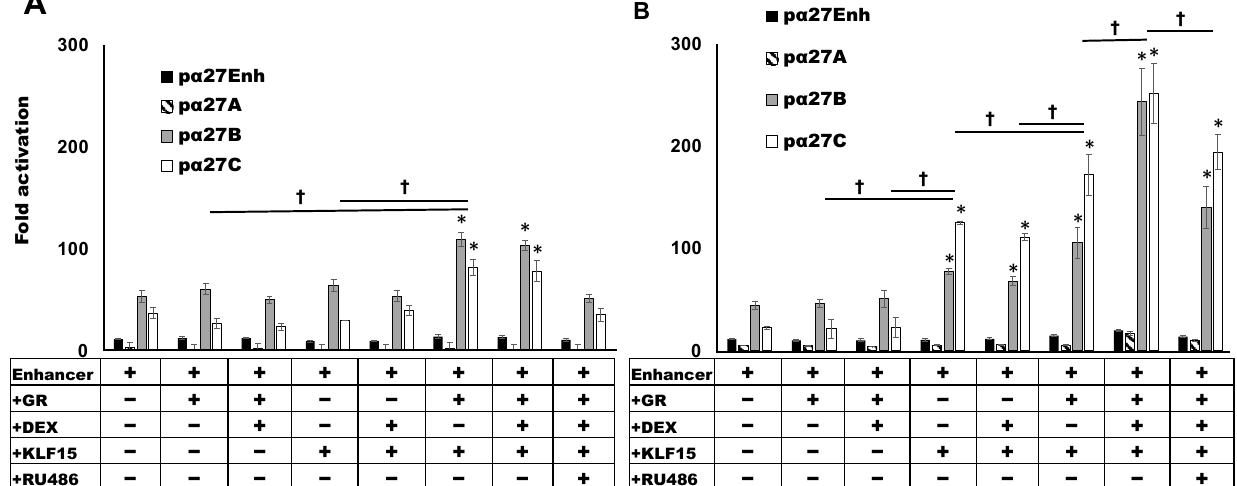
Figure 3. Transactivation of ICP27 enhancer activity by GR and KLF15. Neuro-2A (Panel ( A )) or Vero (Panel ( B )) cells were cultured in MEM containing 10% FBS. Two hours prior to transfection, media were replaced with MEM containing 2% charcoal stripped FBS. Cells were transfected with pGL4.24[luc2P/minP] luciferase reporter plasmid containing the designated enhancer fragment (0.5 µ g DNA) and a Renilla luciferase expression plasmid (0.05 µ g) as a transfection control. Where indicated, cells were co-transfected with the GR (1 µ g DNA) and/or KLF15 (0.5 µ g DNA) expression plasmid. Empty vector was added as needed to maintain equal amounts of DNA in each reaction. Certain cultures were treated with DEX (10 µ M) or RU486 (10 µ M) 24 h following transfection. At 48 h post transfection, cells were harvested, and luciferase assays performed as described in the materials and methods. Promoter activity was calculated as a ratio of firefly to Renilla luciferase activity. Fold activation in each sample is relative to the pGL4.24[luc2P/minP] minimal promoter alone. Results are the mean of three separate experiments, and error bars indicate the standard error. An asterisk (*) denotes statistical significance between the indicated sample and the enhancer alone. A dagger ( † ) indicates significant differences between designated treatment groups for p α 27B and p α 27C enhancer fragments, as determined by Student’s t-test ( p < 0.05).